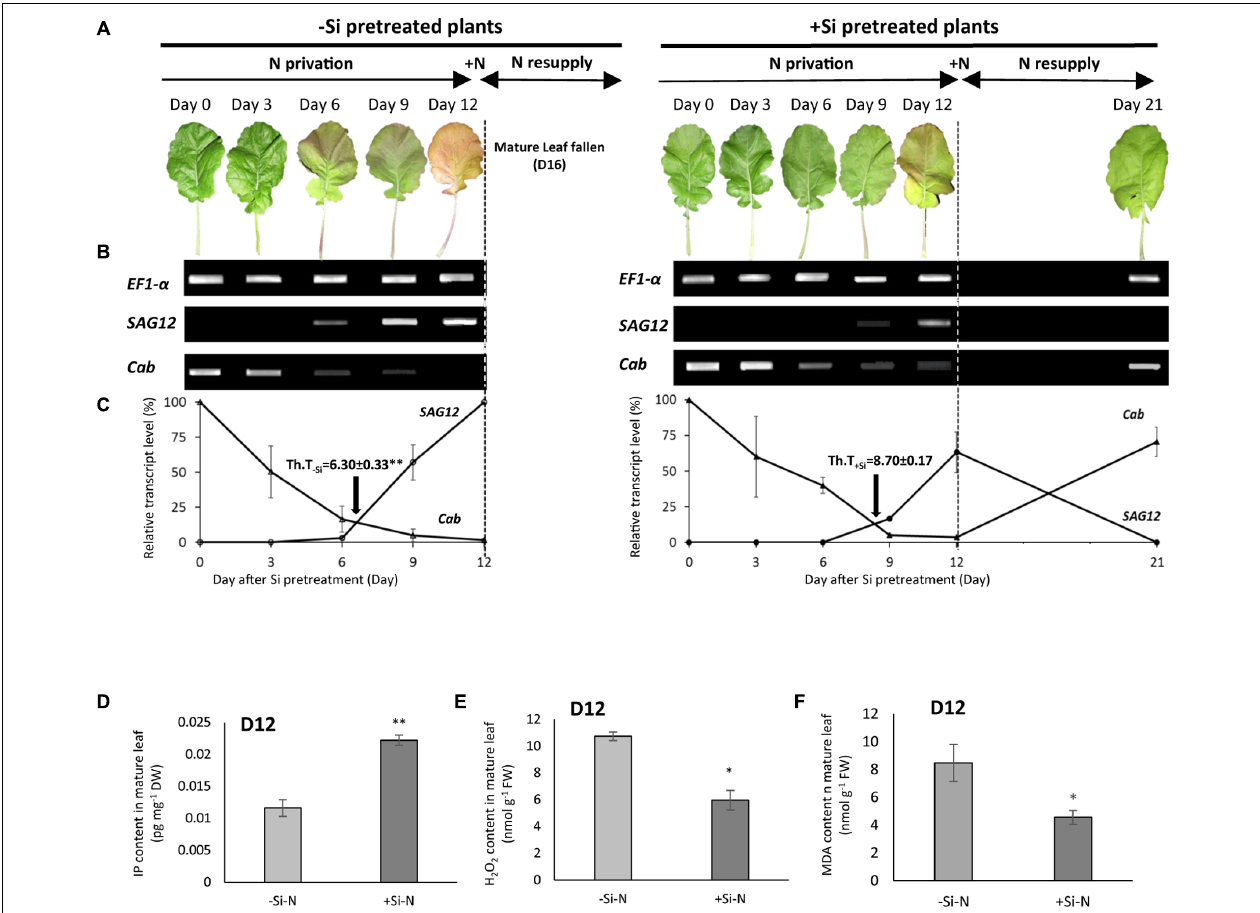
FIGURE 6 | Images, changes in SAG12/Cab molecular senescence indicators and active cytokinin, hydrogen peroxide, and malondialdehyde contents in mature leaf from N-deprived Brassica napus pretreated or not with Si. (A) Images of mature leaf from plants pretreated without (–Si) or with Si (+Si) cultivated during 12 days without N (–N; from D0 to Day 12) and resupply with N (+N; from Day 12). (B) BnaSAG12 and Cab gene expressions monitored by RT-PCR in mature leaves harvested after 0, 3, 6, 9, and 12 days of N starvation and 9 days after N resupply (day 21). EF1- α was used as a cDNA synthesis and amplification control. (C) Quantification of BnaSAG12 and Cab transcripts using ImageLabTM software after normalization with the EF1- α gene. Arrows indicate the theoretical time (Th.T.) of the onset of senescence of mature leaf determined as previously described by Gombert et al. (2006). (D) Active cytokinin (N 6 -Isopentenyladenine: IP) content in mature leaf at 12 from plants pretreated without (–Si) or with (–Si) Si and cultivated without N (–N) during 12 days (From D0 to D12). (E) Hydrogen peroxide (H 2 O 2 ) content in mature leaf at 12 from plants pretreated without (–Si) or with (–Si) Si and cultivated without N (–N) during 12 days (From D0 to D12). (F) Malondialdehyde (MDA) content in mature leaf at 12 from plants pretreated without (–Si) or with (–Si) Si and cultivated without N (–N) during 12 days (From D0 to D12). Data are means ± SE (for n = 3). ∗ and ∗∗ indicate significant differences between –Si and +Si plants with p < 0.01 and p < 0.05, respectively.